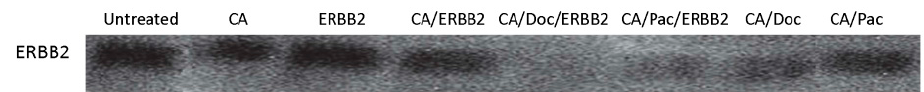
10 of 15 Figure 3. AKT protein expression in MCF-7 cells. Cells were treated with media (untreated), carbonate apatite, free AKT siRNA, CA/AKT siRNA, CA/AKT/Pac, and CA/Pac. Ingredients include 3 mM of CaCl 2 , 1 nM siRNA, and 1 nM Pac. Cellular lysates were run in SDS-PAGE and transferred into PVDF membrane and incubated with primary antibodies raised in rabbit against AKT. HRP-conjugated goat anti-rabbit secondary antibody was used to detect the chemiluminescent signals. The same synergistic pattern, but with a lower potency, was observed with application of CA/AKT/Doc in the downregulation of AKT protein against CA/AKT or CA/Doc (Figure 4). Figure 4. AKT protein expression in MCF-7 cells. Cells were treated with media (untreated), carbonate apatite, free AKT siRNA, CA/AKT siRNA, CA/AKT/Doc, and CA/Doc. Ingredients include 3 mM of CaCl 2 , 1 nM siRNA, and 1 nM Doc. Cellular lysates were run in SDS-PAGE and transferred into PVDF membrane and incubated with primary antibodies raised in rabbit against AKT. HRP-conjugated goat anti-rabbit secondary antibody was used to detect the chemiluminescent signals. Based on a substantial enhancement in efficacy, the impact of different combinations of ERBB2